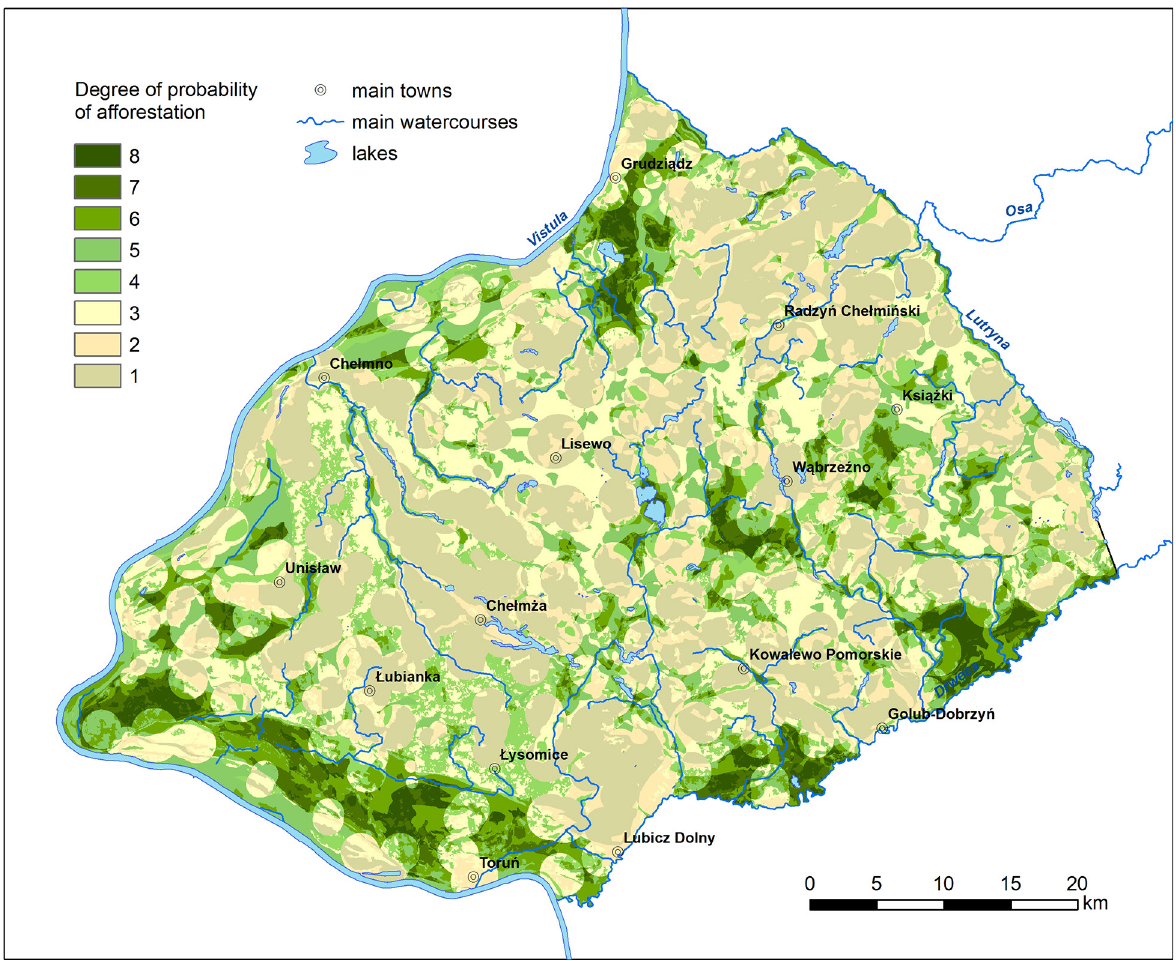
Fig. 11. Spatial model of forest area occurrence in Chełmno Land in the 13th